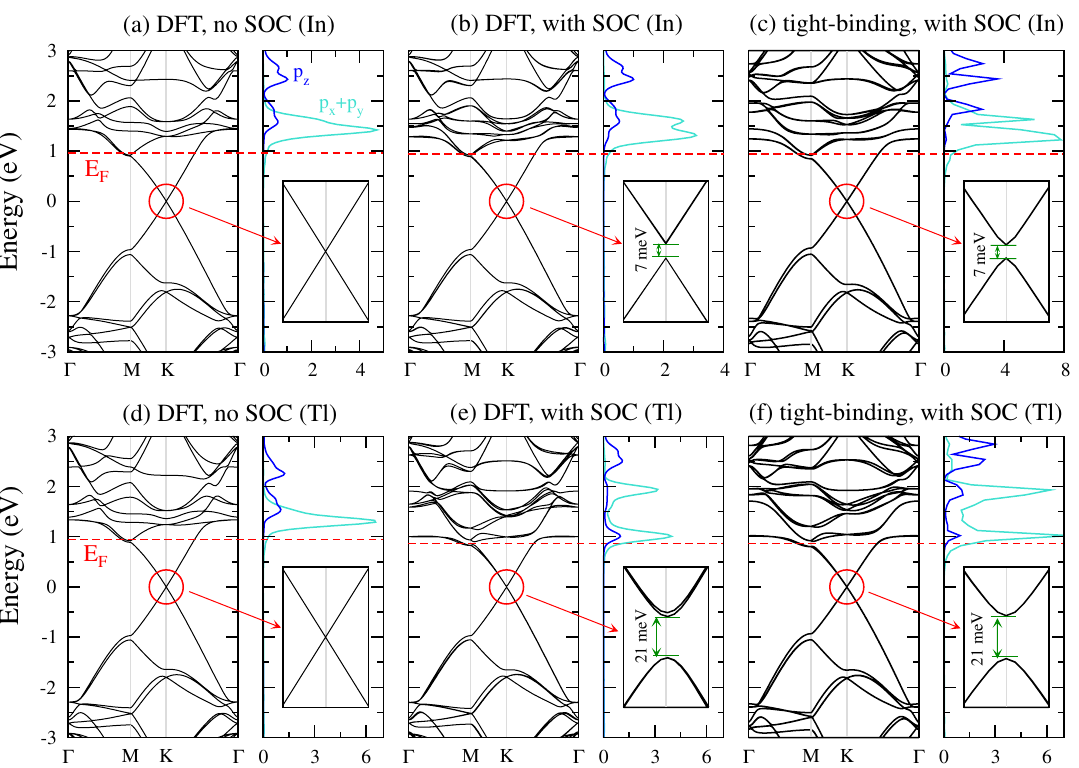
FIG. 2. Band structure and the adatom local density of states (LDOS). All data correspond to one adatom in a 4 (cid:3) 4 supercell, with the upper row corresponding to indium and the lower row corresponding to thallium. The left panels in (a) and (d) correspond to the band structure and LDOS computed using DFT without spin-orbit coupling. The horizontal dashed red lines indicate the Fermi level ), which shifts due to electron-doping from the adatoms. Insets zoom in on the band structure near the K point within an energy ( E F range (cid:1) 35 to 35 meV, showing that, without spin-orbit interactions, neither indium nor thallium opens a gap at the Dirac points. The central panels in (b) and (e) are the corresponding DFT results including spin-orbit coupling. Remarkably, in the indium case, a gap of 7 meV opens at the Dirac points, while, with thallium, the gap is larger still at 21 meV. Finally, the right panels in (c) and (f) were obtained using the tight-binding model described in Sec.